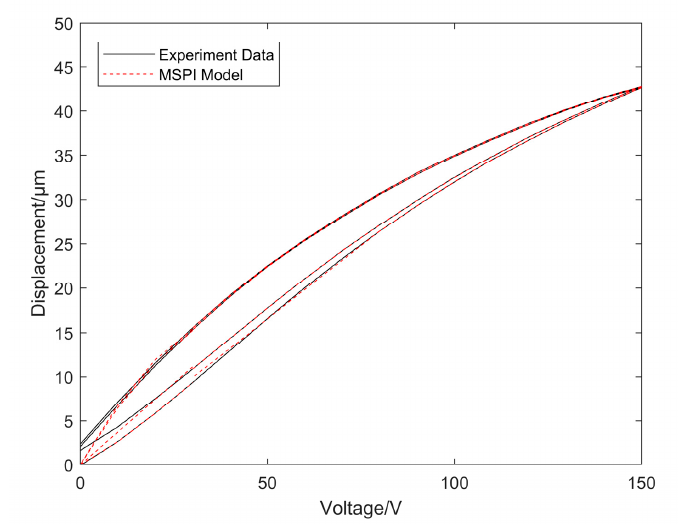
Figure 22. Hysteresis feature modeling of MSPI model.